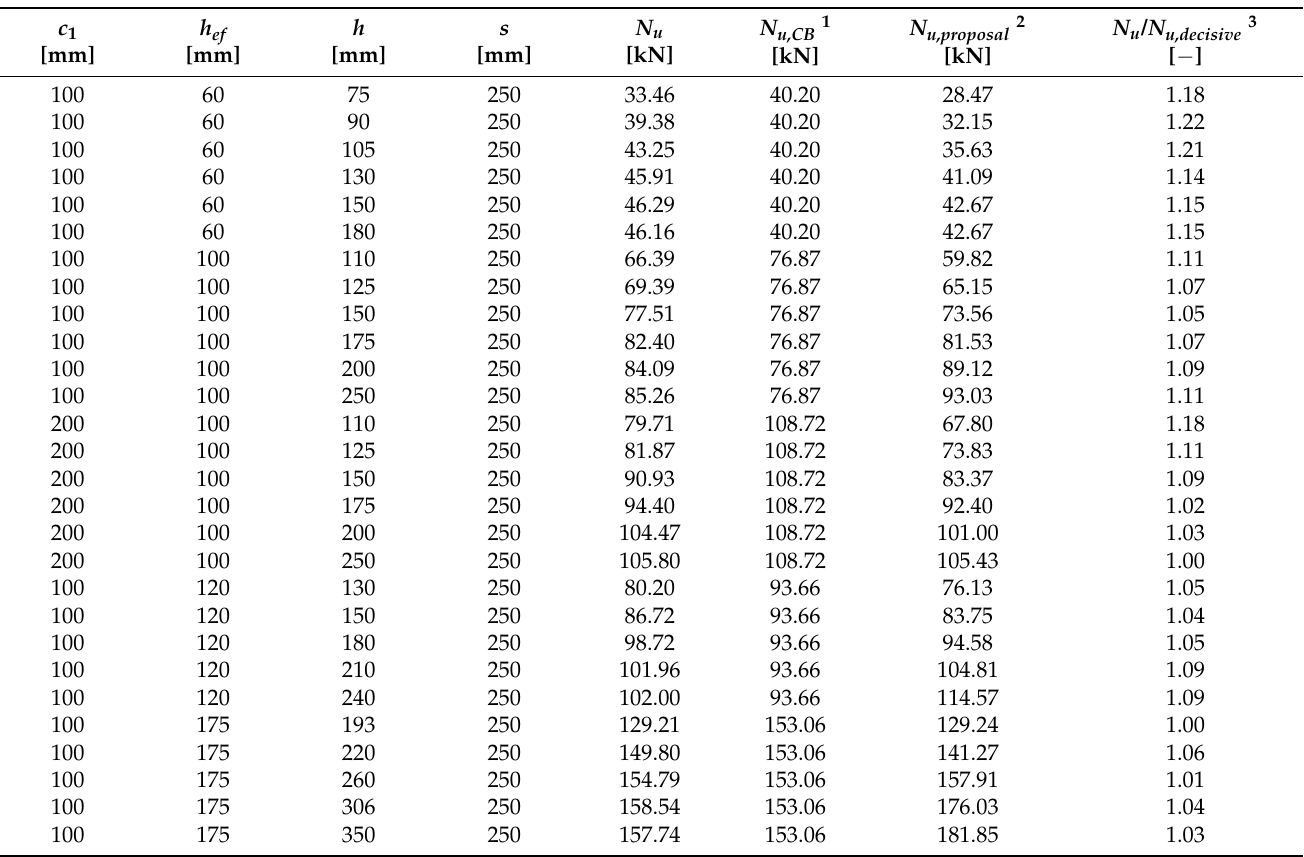
Table A1. Numerical simulations—influence of member